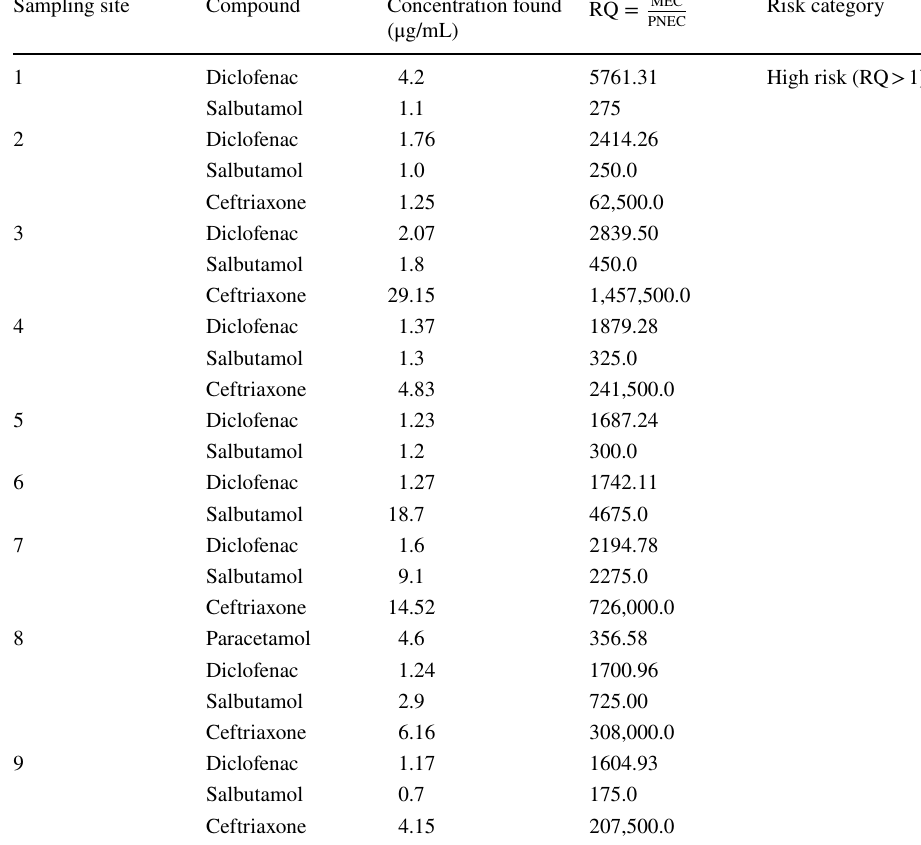
Table 4 Risk quotients of pharmaceutical compounds in water samples (Sites